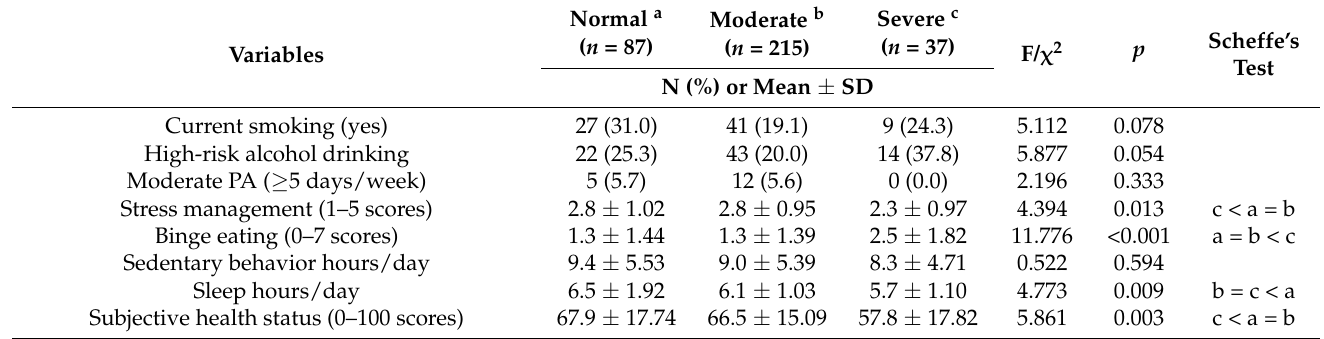
Table 3. Health Behavior and Subjective Health, According to Fear of COVID-19.